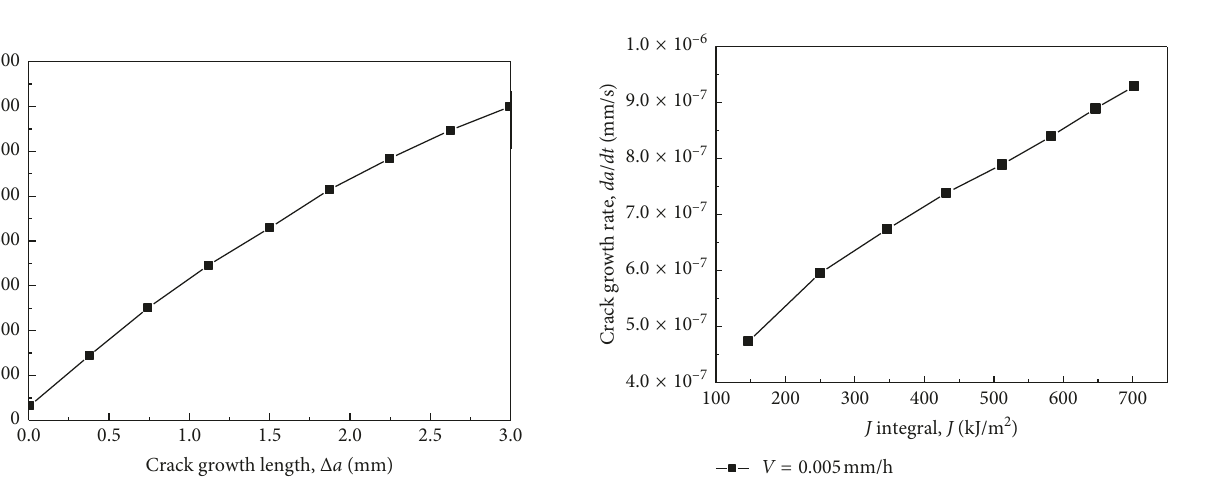
Figure 11: The relationship between crack growth length and stress intensity factor.